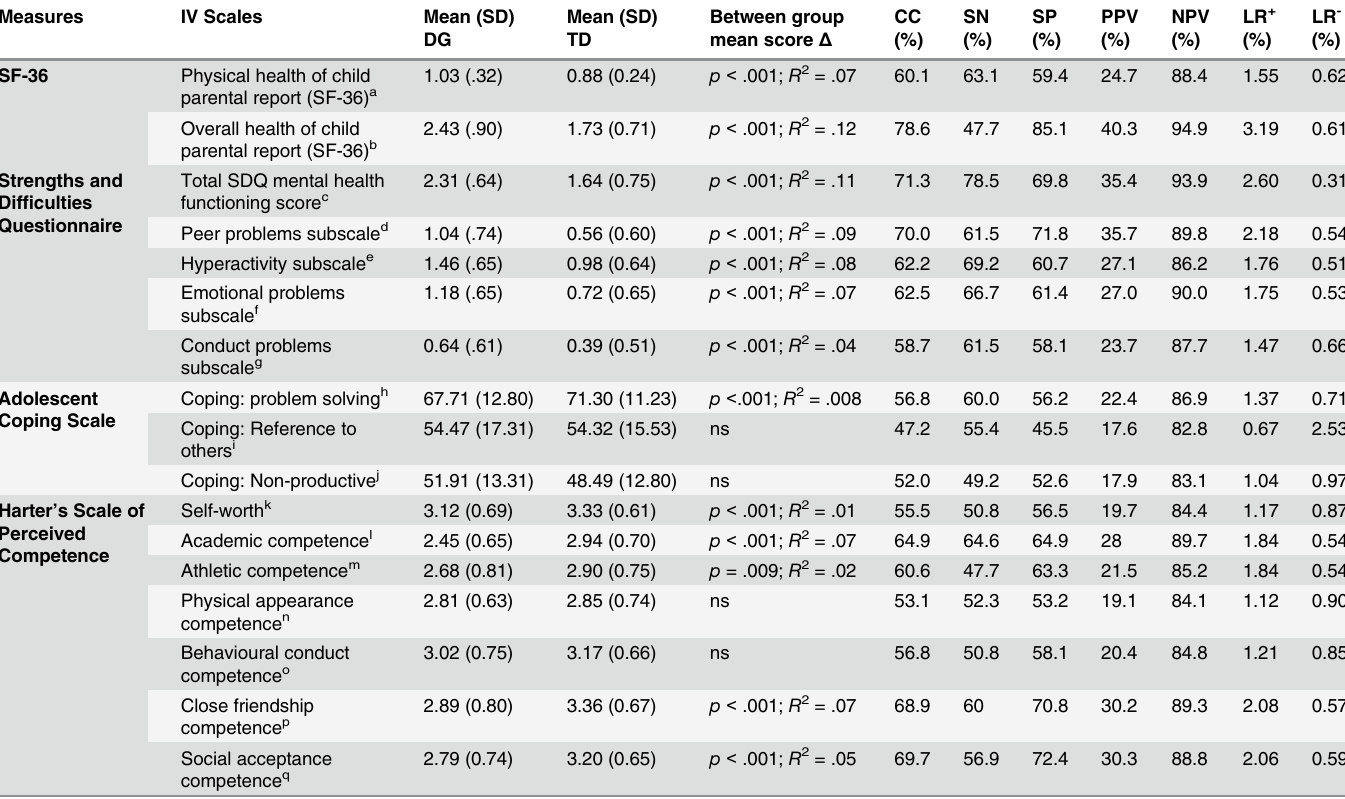
Table 1. Ability of rating of child ’ s physical and mental health functioning in differentiating disability in a community mainstream school sample.